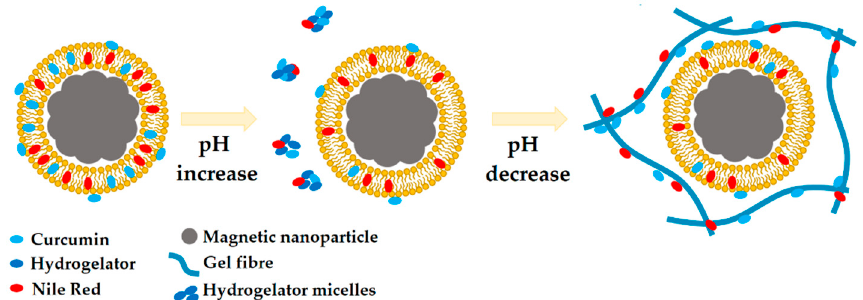
Figure 6. Scheme of the proposed process of incorporation of SMLs containing curcumin (that becomes more water soluble at high pH) and Nile Red in a supramolecular dehydrodipeptide hydrogel activated through GdL-induced slow pH decrease. Upon combination of the SMLs with the basic pH hydrogelator solution, both curcumin and Nile Red are released and accumulate in the hydrophobic cavities of the hydrogelator micelles. As the pH is lowered, both molecules can accumulate in both the hydrophobic cavities of the hydrogel matrix and the SMLs membrane.